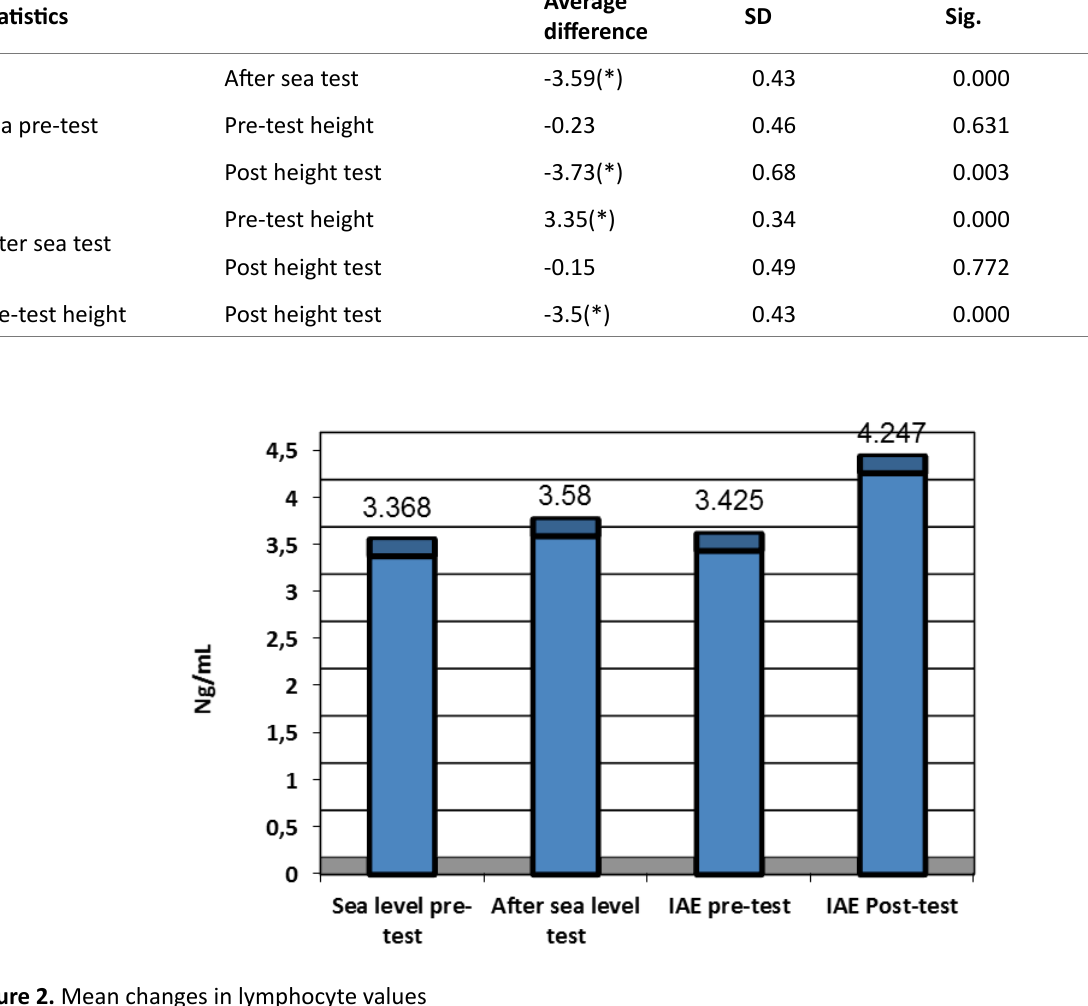
Figure 2. Mean changes in lymphocyte